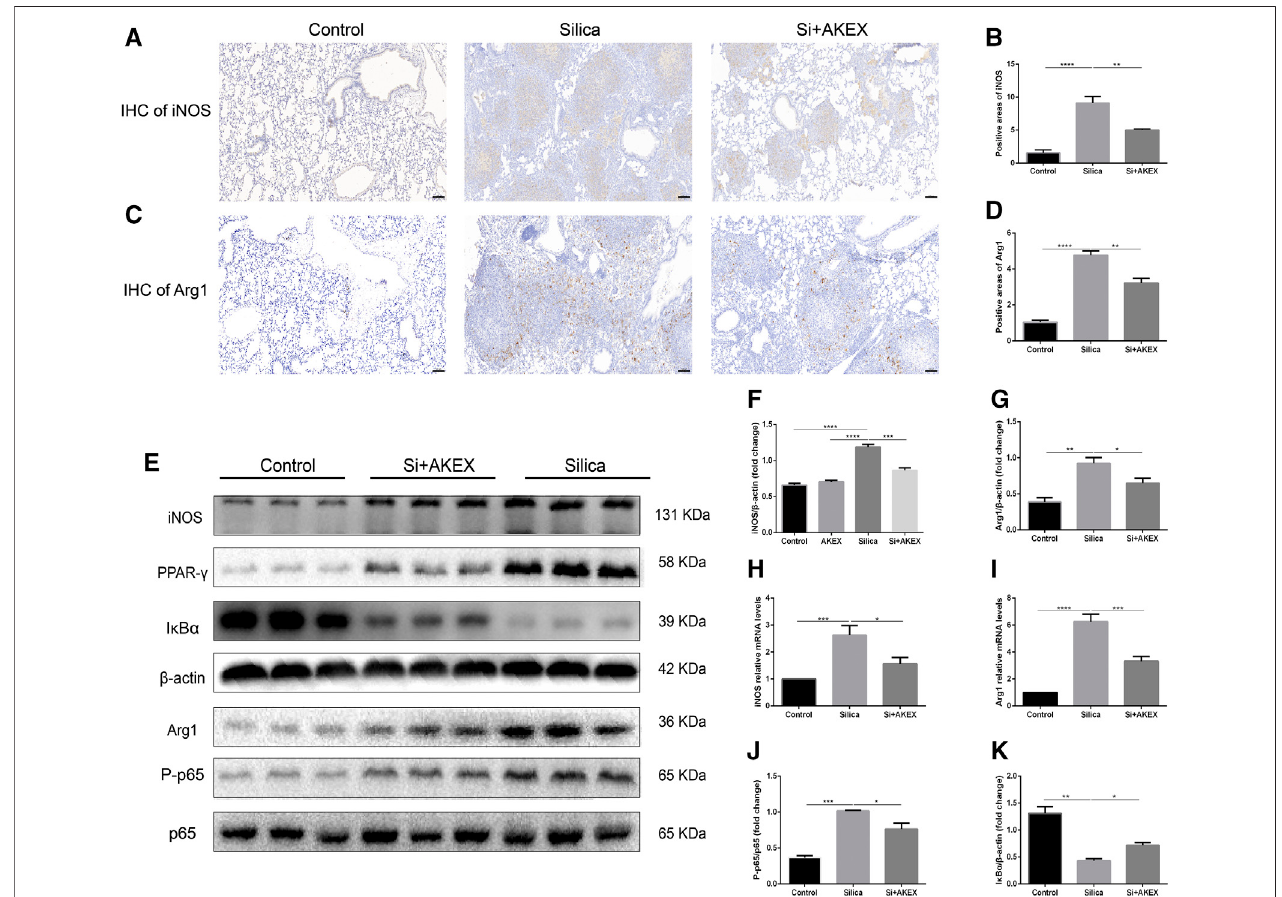
FIGURE8| AKEX0011regulatedpolarizationofpulmonarymacrophagesinthesilicosismousemodel. (A,B) IHCstainingandquanti fi cationoftheM1macrophage markeriNOS(originalmagni fi cation×100)(n=3). (C,D) IHCstainingandquanti fi cationoftheM2macrophagemarkerArg1(originalmagni fi cation×100)(n=3). (E) WBof iNOS,p65, P-p65,PPAR- γ ,I κ B α ,andArg1. β -actinwasusedasaloadingcontrol. (F,G,J,K) Quanti fi cationofbanddensitiesfromWBimagesin(e). (H,I) mRNAlevelsof iNOS and Arg1 in lung tissues detected by qPCR(n = 4-5). All data were presented as mean ± SEM; * p < 0.05, ** p < 0.01, and *** p < 0.001.